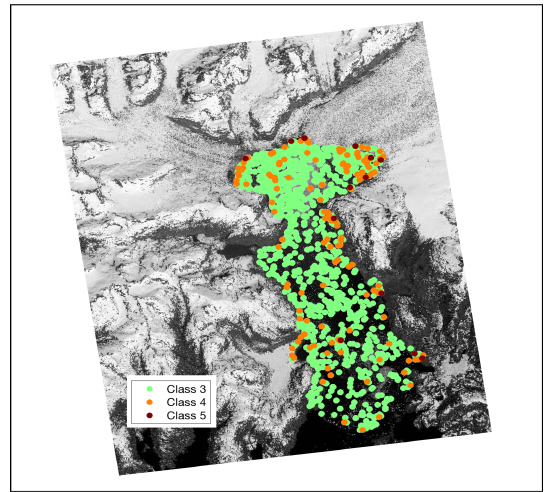
Figure 8. Location of large icebergs by centroid (6a May). Icebergs in Class 3, Class 4, and Class 5 have waterline cross-sectional areas of 100–1000m 2 , 1000–10000m 2 , and 10000–100000m 2 , respec- tively. The background satellite image was taken by WorldView 1 on 10 June 2013 (© 2013 Digital Globe, Inc.).